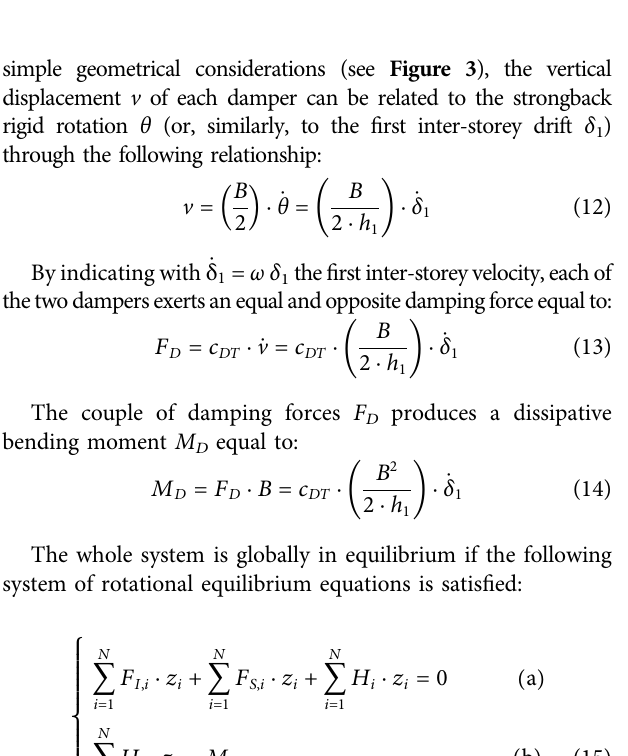
FIGURE 3 | Dynamic forces acting on the DT